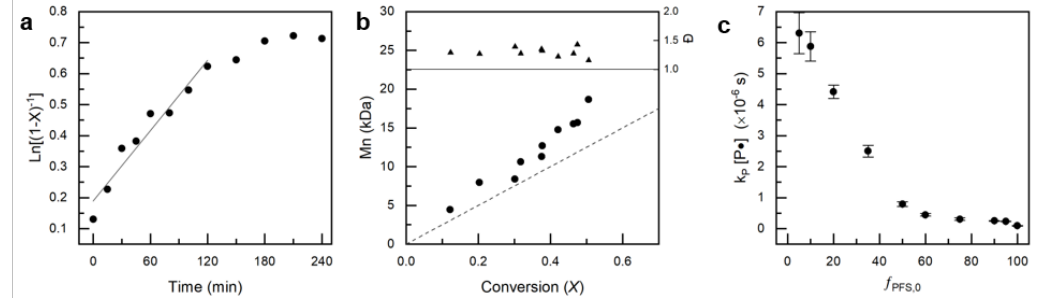
− 1 ] Figure 3. ( a ) Characteristic kinetic plot of ln [( 1 − X ) vs copolymerization time for experiment Figure 3. ( a ) Characteristic kinetic plot of ln[(1 − 𝑋) −1 ] vs copolymerization time for experiment PFS / MMA-05 / 95. ( b ) Progression of experimental number average molecular weight, M n , and PFS/MMA-05/95. ( b ) Progression of experimental number average molecular weight, 𝑀 𝑛 ̅̅̅̅ , and dispersity, Đ , with conversion, X for experiment PFS/MMA-05/95. ( c ) Molar feed ratio of PFS, f PFS,0 dispersity, Ð , with conversion, X for experiment PFS / MMA-05 / 95. ( c ) Molar feed ratio of PFS, f PFS,0 versus apparent rate constant, k p [P•] found from the kinetic plots slope. versus apparent rate constant, k p [P • ] found from the kinetic plots